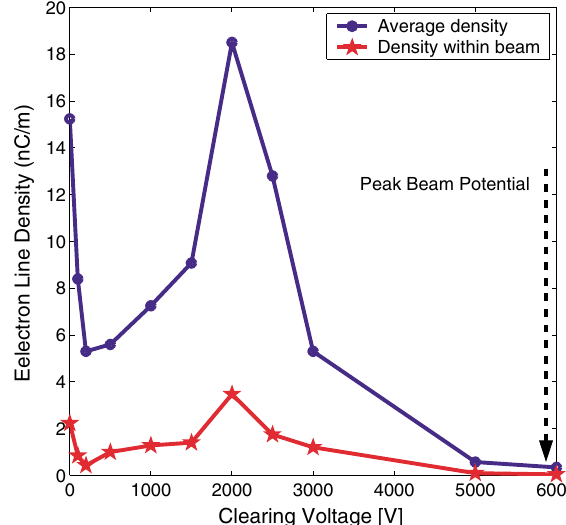
FIG. 6. (Color) Variation of the peak line density of the elec- tron cloud with various clearing potentials in the SNS’s drift region.